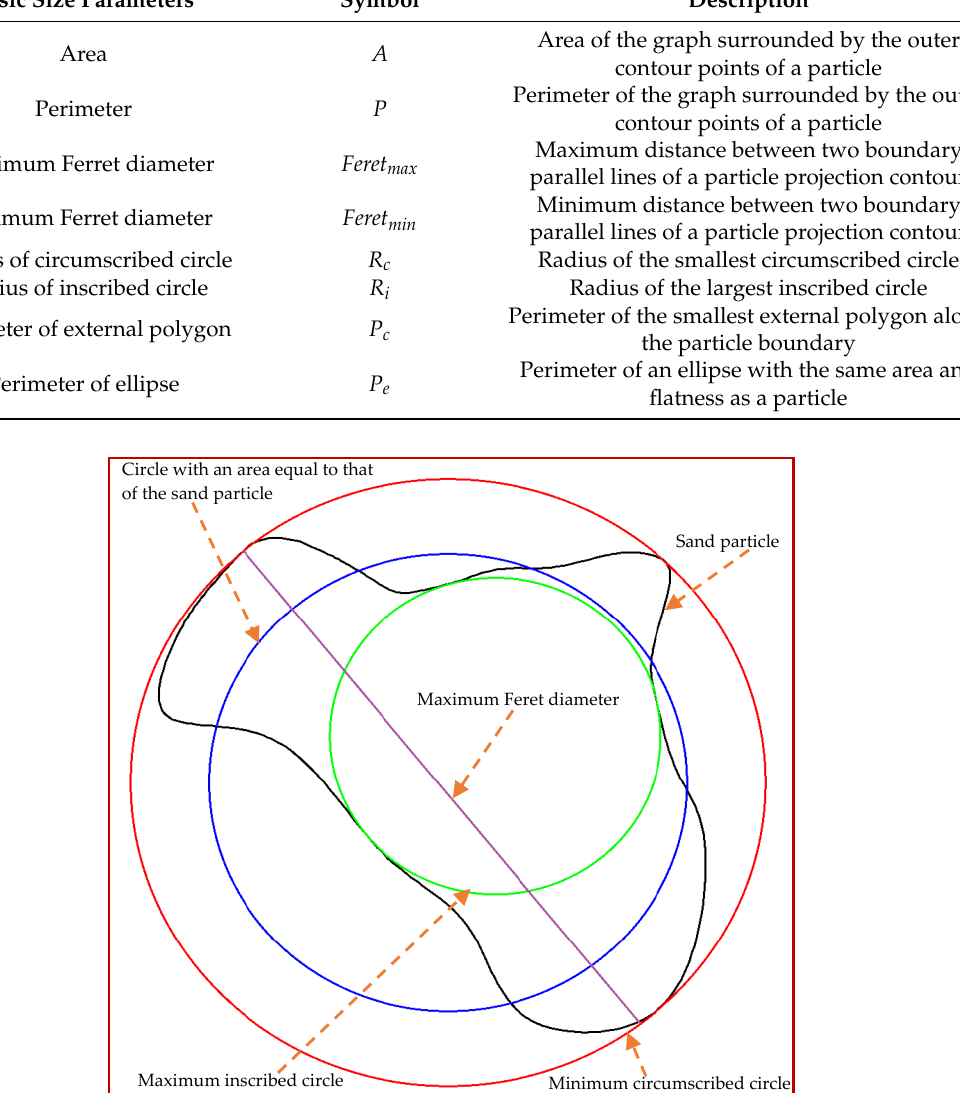
Surface textures at the micro level